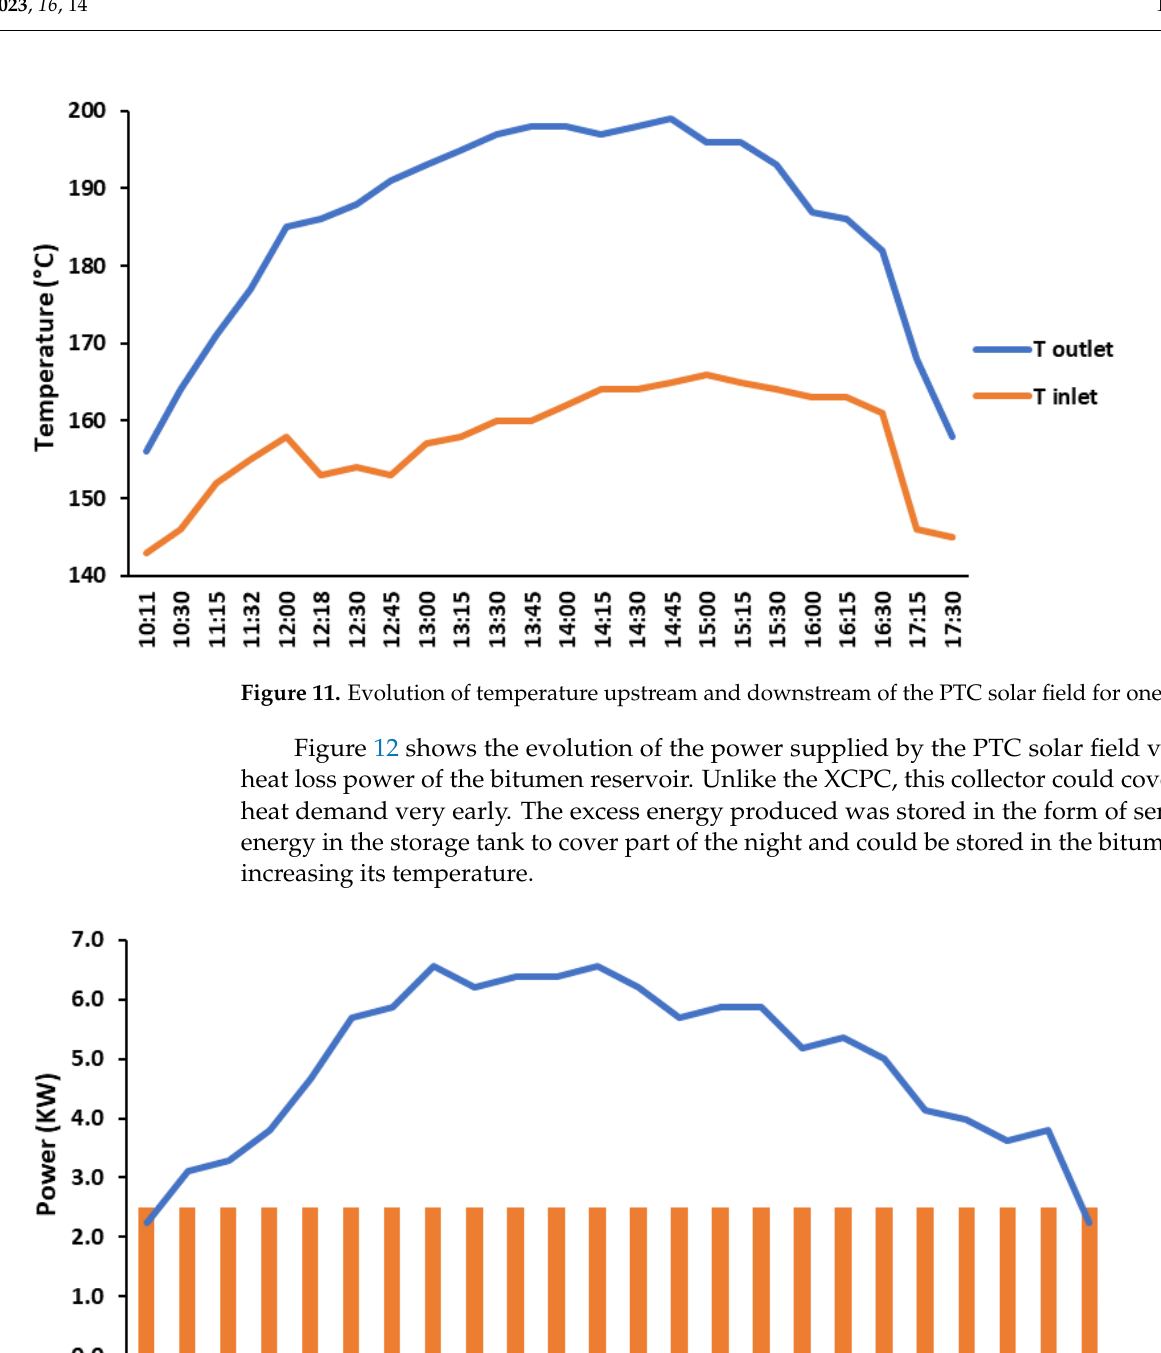
Figure 13. The measured energy flow from the PV panel (6.24 kWp) [46]. The experimental setup showed the feasibility of heating up a bitumen storage tank with solar energy. A sizing study taking in consideration the meteorological conditions and the available area in the bitumen plant has to be performed to identify the solar frac- tion that could be covered by solar energy. Mokhtar et al. [29] conducted a sizing study with the main objective of providing an optimized design and management to minimize the energy cost (EC) and maximize the renewable energy utilization fraction (REF). 3.3. Physical Property Evaluation An examination of Figure 14 revealed that no remarkable change occurred in the penetration values after any thermal treatment. At the unaged stage, the neat bitumen’s penetration was 40 (0.1 mm) , and the thermally cycled samples had values between 39 and 41 (0.1 mm) . After short-term aging, the neat bitumen had a value of 26 (0.1 mm) , and the other samples had values between 25 and 27 (0.1 mm) . After long-term aging, almost all the samples had values of 15 (0.1 mm) . The difference of 1 (0.1 mm) was a negligible